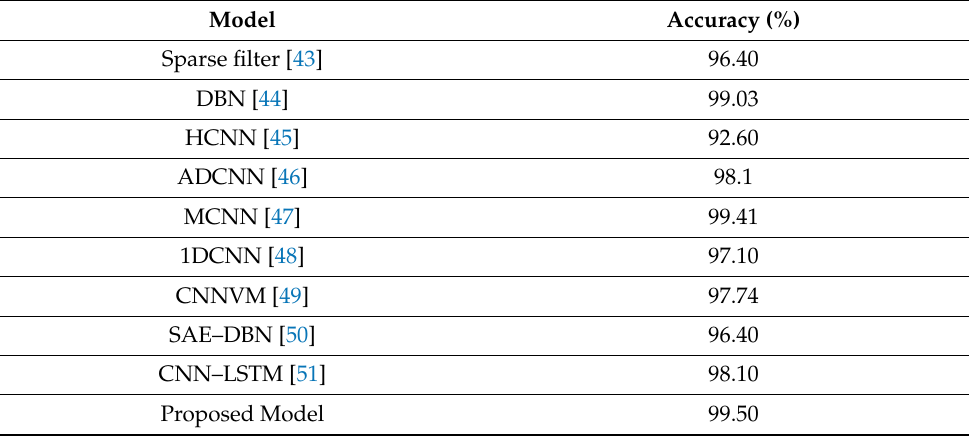
Table 3. Comparison of the proposed model with various DL-based FD